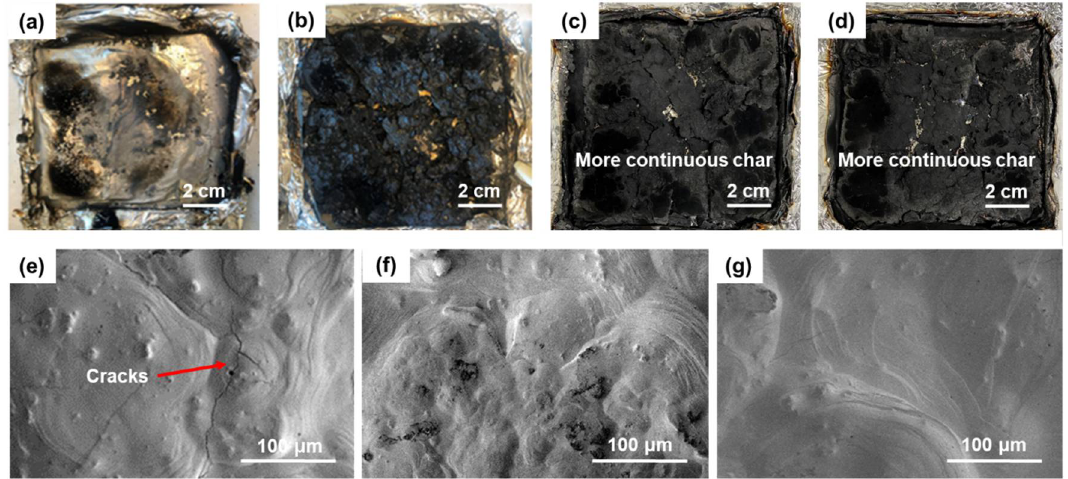
Figure 6. Char residue of ( a ) pure EVA, ( b ) EM, ( c ) EMC3, and ( d ) EMC5 composites after Cone test; SEM images of: ( e ) EM, ( f ) EMC3, and ( g ) EMC5 char residue.